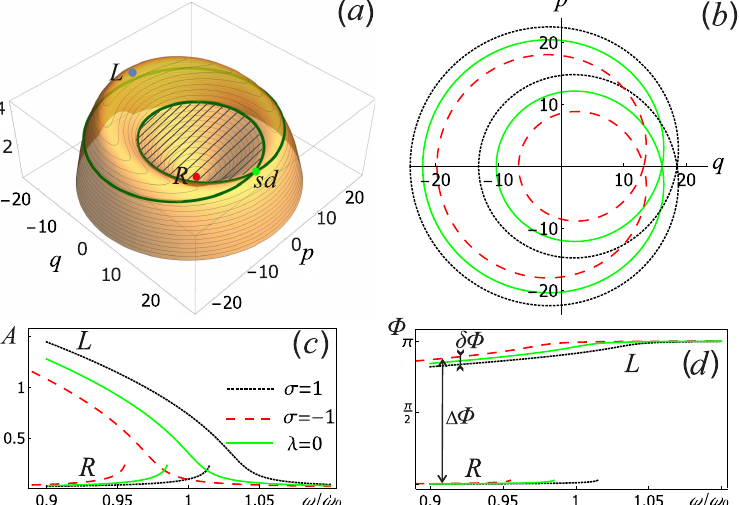
Figure 2. ( a ) The quasi-energy surface H osc ( q , p ) is represented in units of ¯ h ω 0 . The capture area in the right equilibrium point corresponds to the shaded area S R . The left and right equilibrium points are denoted by the symbols L and R , respectively, and sd is the saddle point. The separatrix ( b ), amplitude ( c ) and phase ( d ) of the stable oscillations of the nonlinear oscillator as a function of the drive current frequency for different qubit states ( σ = ± 1). We assume that there was no connection with the qubit when the coupling parameter is equal to λ = 0. Other parameters are determined by the relations